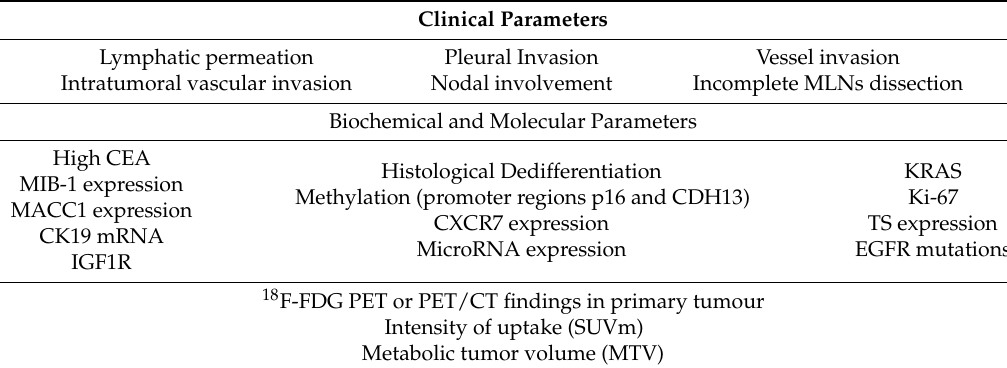
Table 1. Predictors for recurrence of non-small cell lung cancer after complete resection [6,9]. Clinical